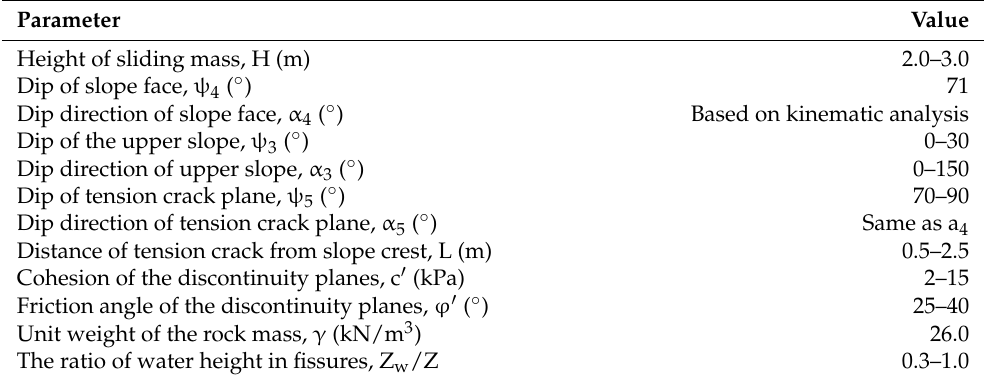
Table 2. Range of values of the parameters to be determined by limit equilibrium back-analyses for wedge failures. Indices in dip and dip direction’s values correspond to the planes shown in Figure